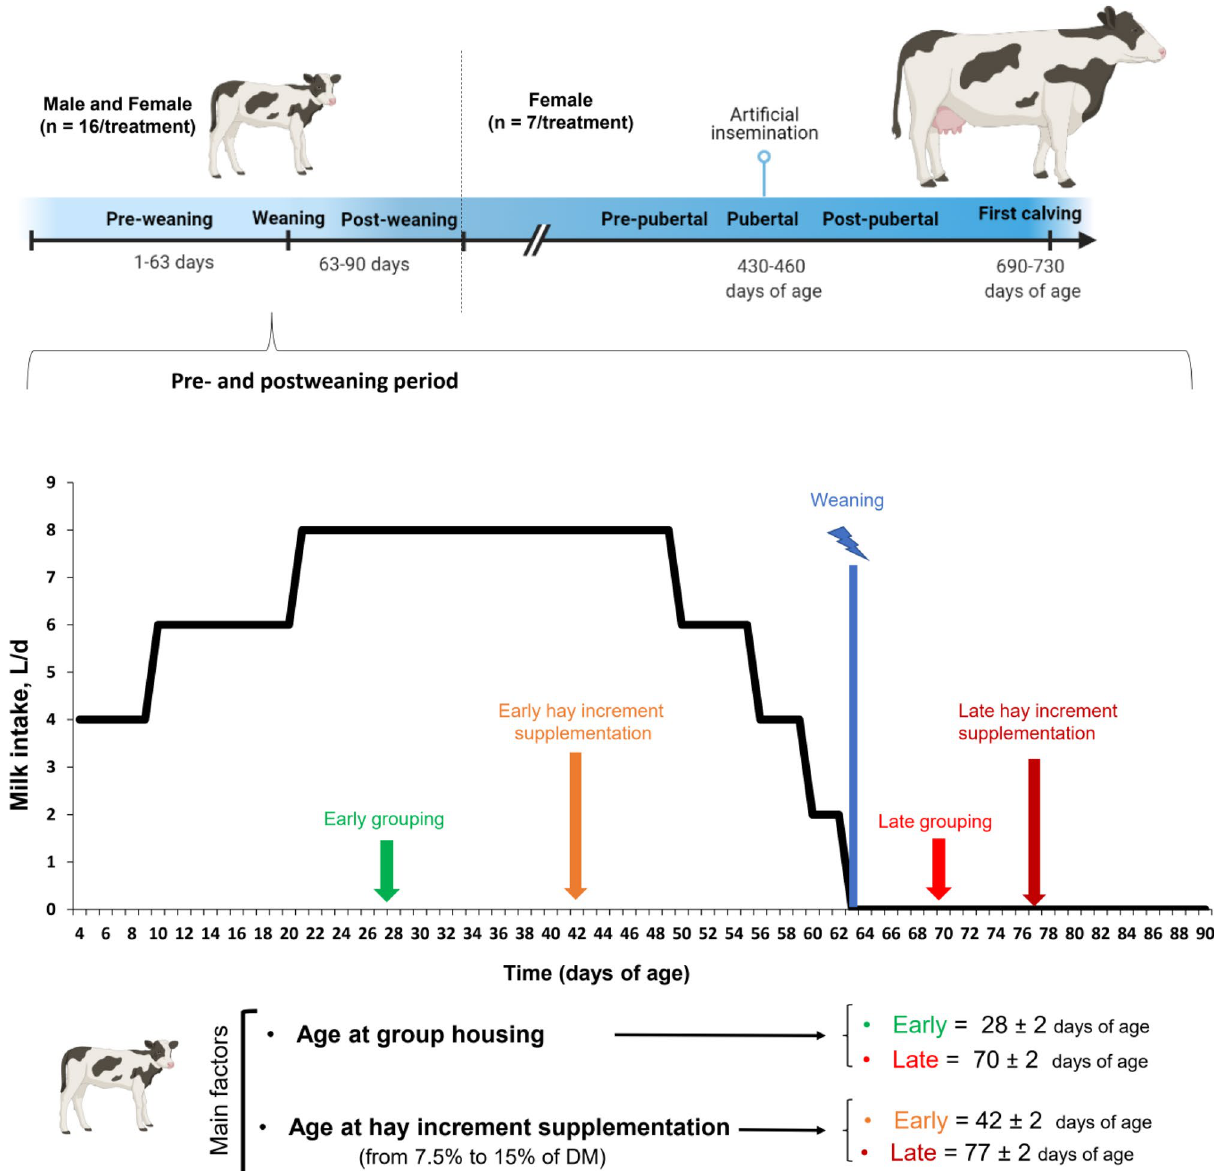
Figure 1. Overview of the animal experiment. A total of 64 calves (n = 16 calves/treatment, 8 male and 8 female) were randomly assigned to 4 treatments in a 2 × 2 factorial arrangement with age at group housing (early = d 28 ± 2, EG vs. late = d 70 ± 2, LG) and age at incremental hay supplementation in calf starters from 7.5 to 15% of DM (early = d 42 ± 2 d, EH vs. late = d 77 ± 2, LH) as main factors (marked with different colors). Treatments included late group housing-late hay increment (LG-LH), late group housing-early hay increment (LG-EH), early group housing-late hay increment (EG-LH), and early group housing-early hay increment (EG- EH). Calves received 4 L/d from day 4 to 9, 6 L/d from day 10 to 20, 8 L/d from day 21 to 49, 6 L/d from day 50 to 55, and 4 L/d from day 56 to 59. Weaning was initiated by limiting milk intake to morning feedings (2 L) from day 60 to 62 of life. Calves were fully weaned at 63 days of age. All calves (female and male) were observed until they were 90 days of age, and heifers were observed until the first calving. Figure created using a web-based program BioRender (https:// app. biore nder.